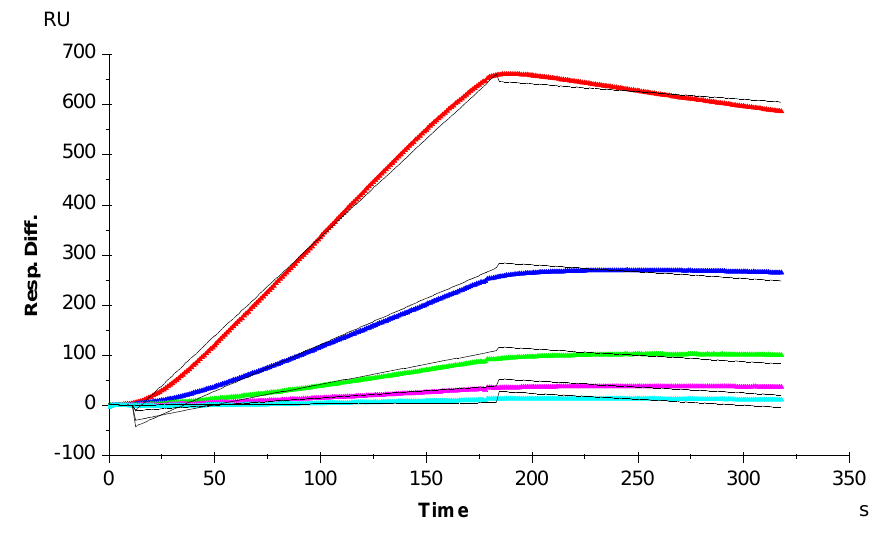
Figure 3. SPR sensorgrams of the TIMP-3-heparin interaction. Concentrations of TIMP-3 (from top to bottom): 20, 10, 5, 2.5, and 1.25 nM, respectively. The black curves are the